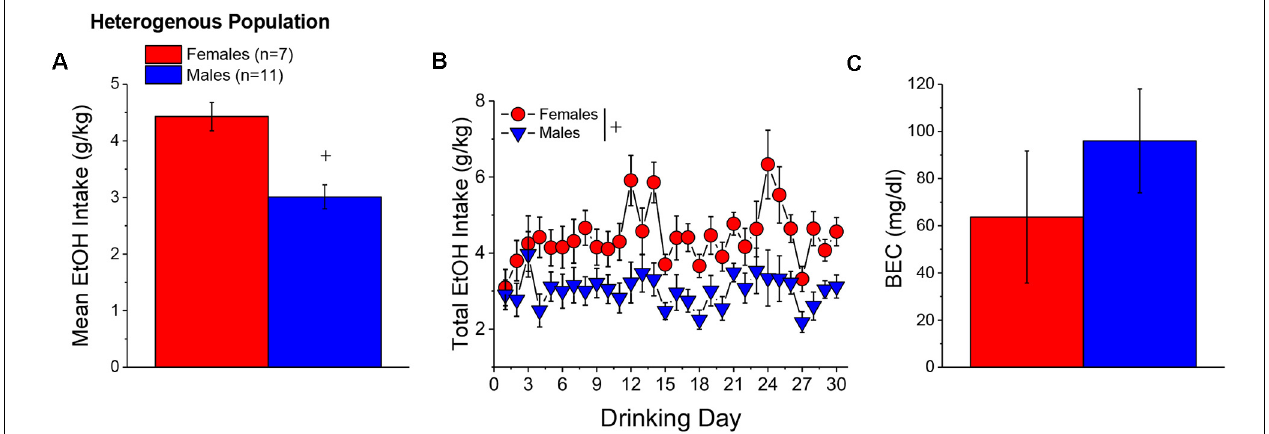
FIGURE 2 | Binge drinking during later maturity (6–9 months of age) in a heterogenous cohort of mice. (A) On average, females in Experiment 1 consumed more alcohol than males over the 30-day course of binge drinking. (B) Comparison of the time-courses of binge drinking between Experiment 1 male and female mice. (C) Despite the sex difference in binge drinking, BECs were comparable between Experiment 1 male and female mice. The data represent the means ± SEMs, adjusted for the covariates of age and background, of the number of mice indicated in parentheses in panel (A) . + p < 0.05 Males vs. Females (sex